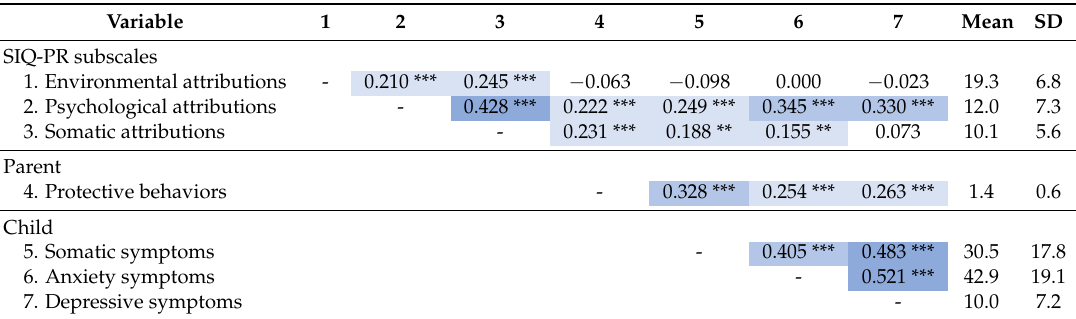
Table 1. Pearson correlation